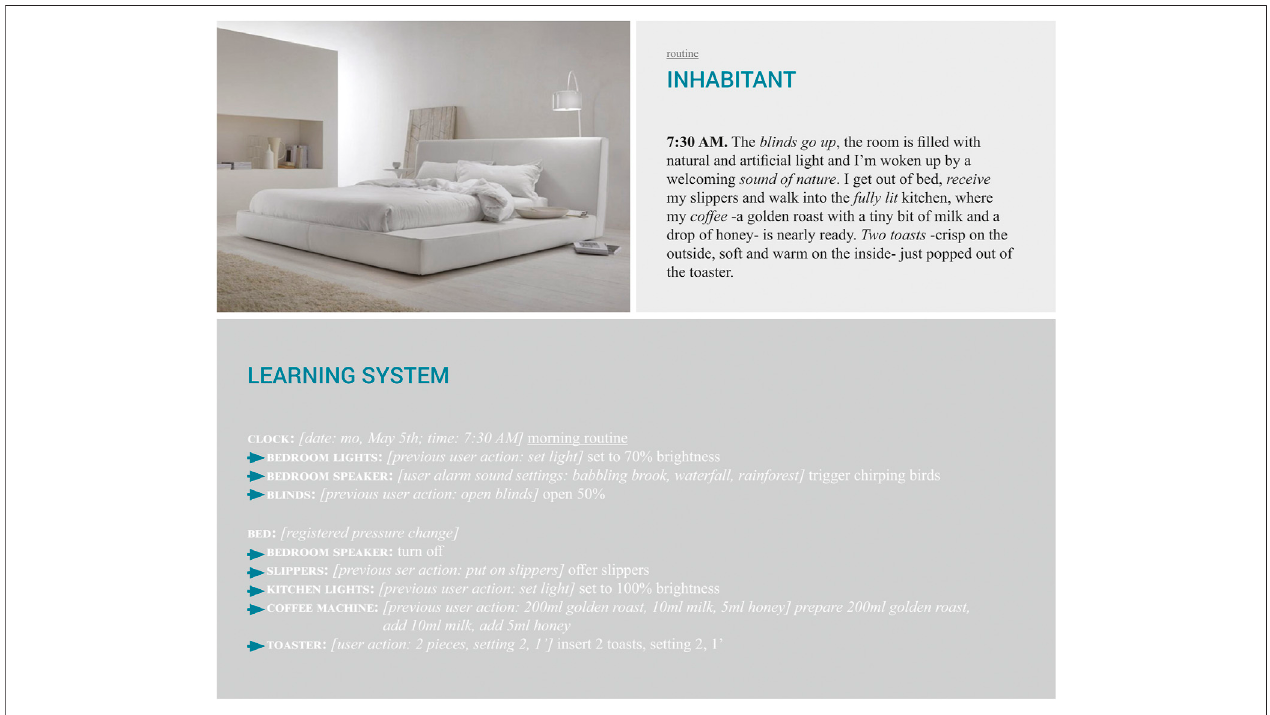
FIGURE 1 | Getting up: routine imaginary (image by Vania,